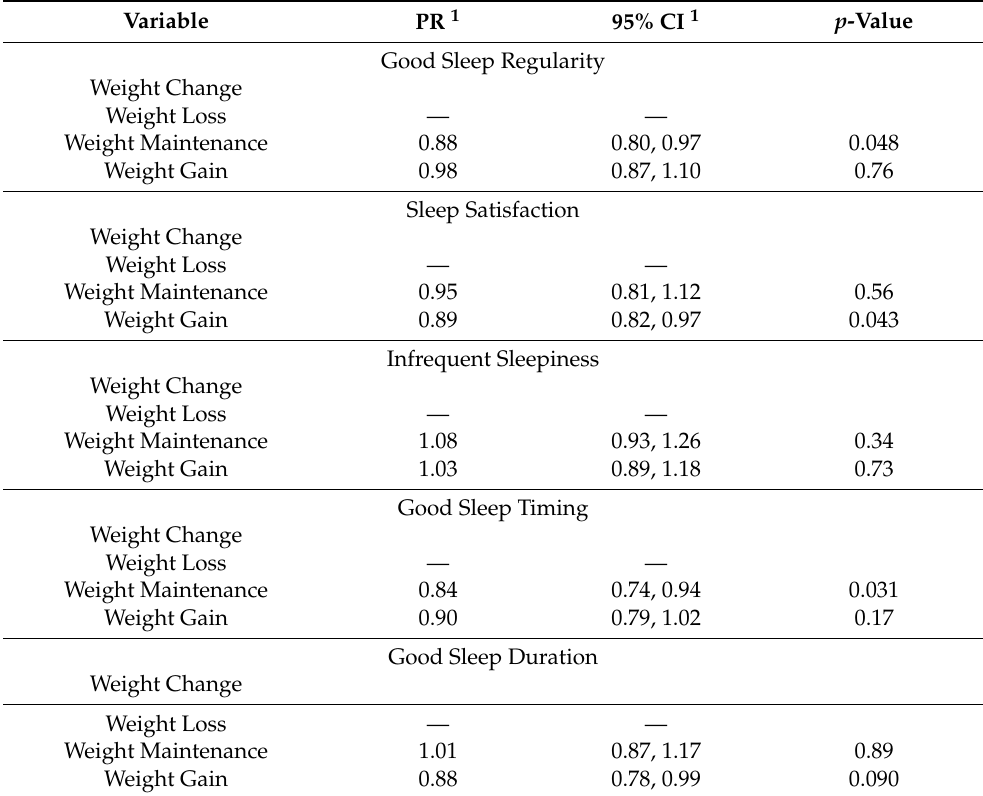
Table 7. Prevalence ratios for good sleep health indicators among adults who attempted weight loss by self-reported weight change in the past